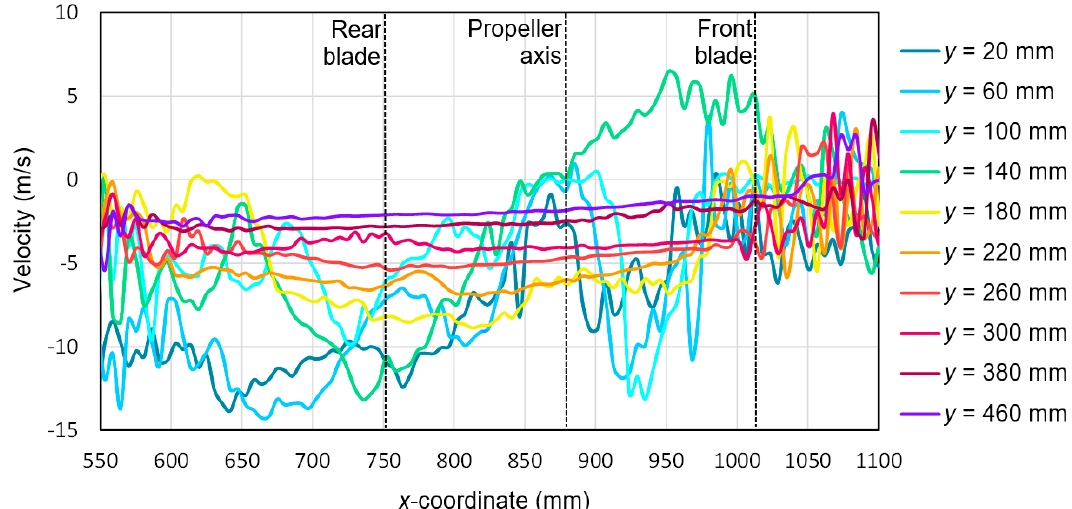
Figure 19. Vertical components of the airflow velocities around the research object for the following configuration: angle of attack α = − 4° and airflow in the wind tunnel v wt = 12.5 m/s.